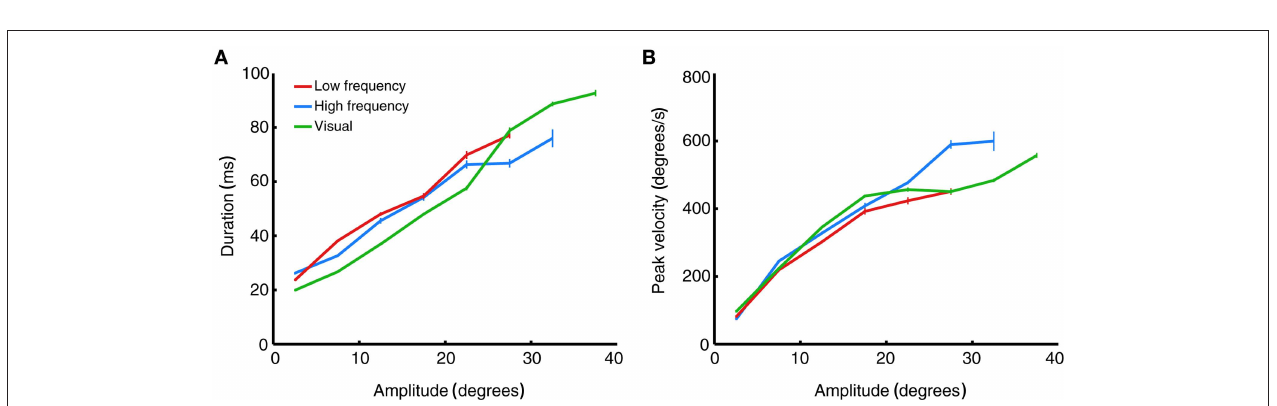
FIgure 9 | Main sequence relations of evoked saccades. (A) Saccade duration as a function of saccade amplitude, binned in 5 ° bins. Data are averaged over all stimulation- (red and blue) or target- (green) evoked saccades in all stimulation sites, regardless of fixation position. Error bars indicate ± 1 SEM. (B) Saccade peak velocity as a function of saccade amplitude. Same saccades and conventions as in (A) .